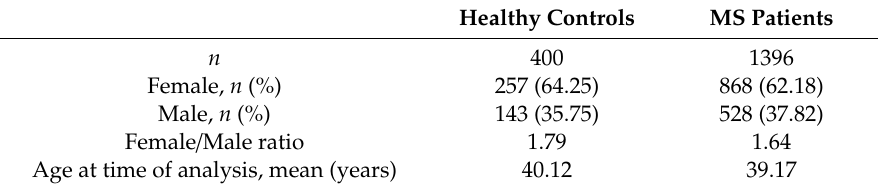
Table 1. Demographic and clinical characteristics of the study